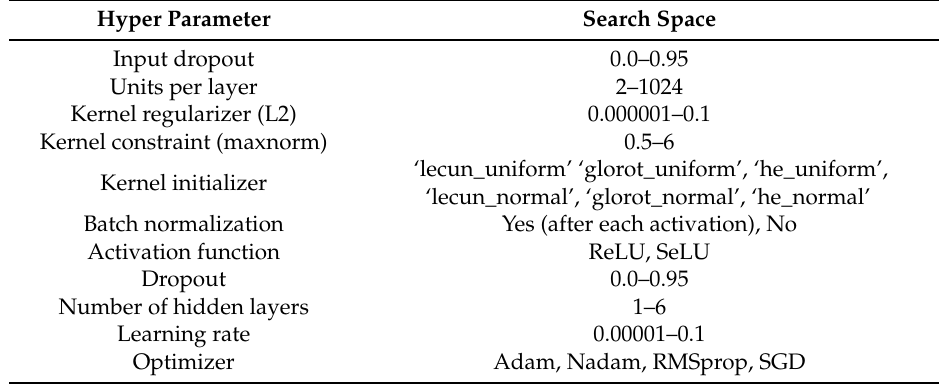
Table 6. Hyper parameter search space using the Tree of Parzen estimator method in